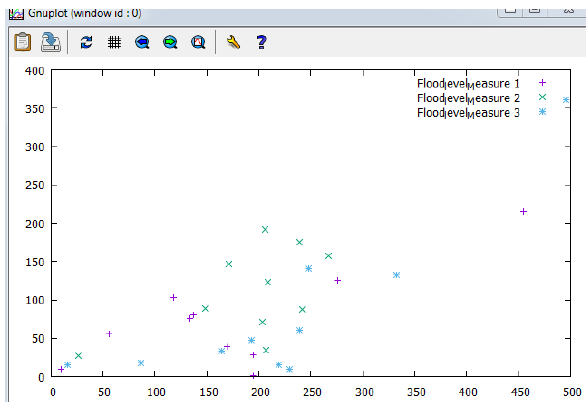
Figure 5. Increasing Flood Level Measure.